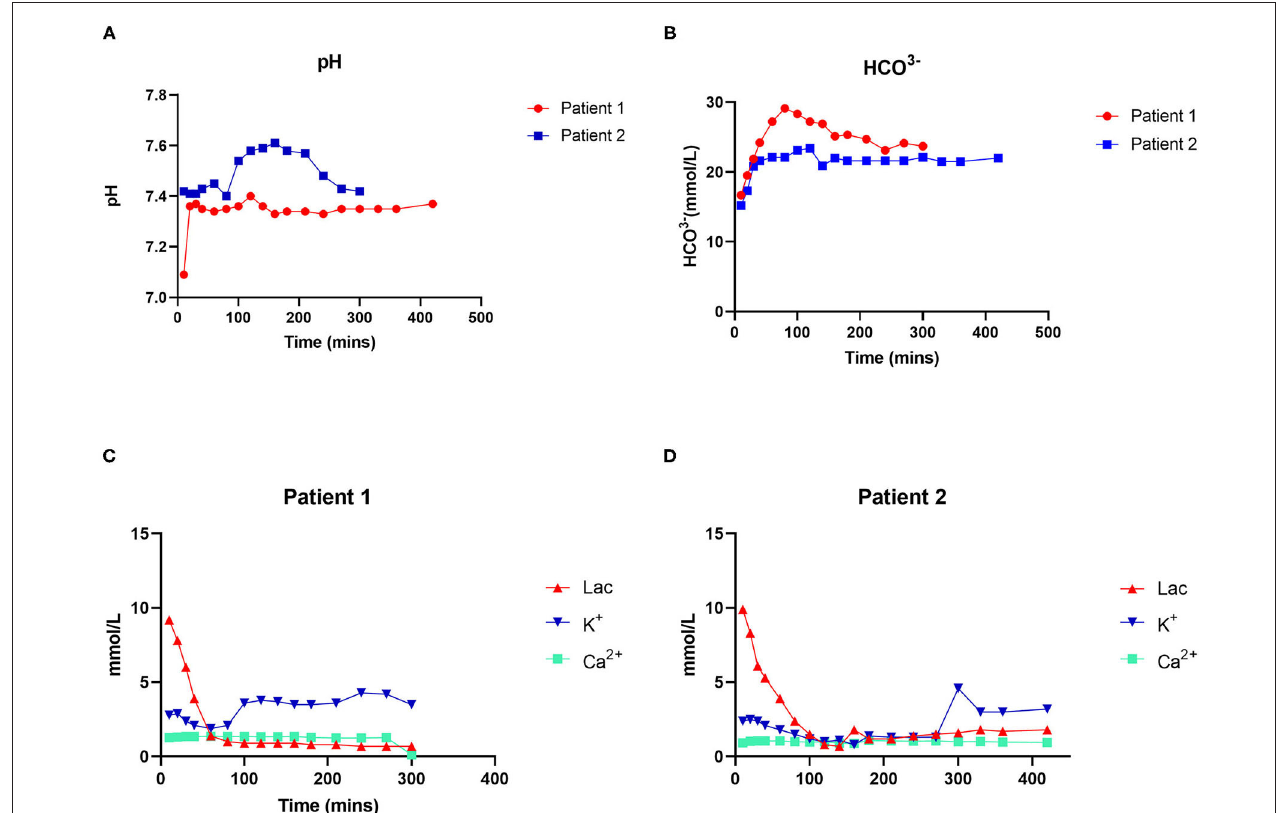
FIGURE 2 | Dynamic changes in physicochemical indexes during perfusion. (A) Changes in pH. (B) Changes in HCO 3 − . (C) Changes in lactate and ion concentrations in patient 1. (D) Changes in lactate and ion concentrations in patient 2.